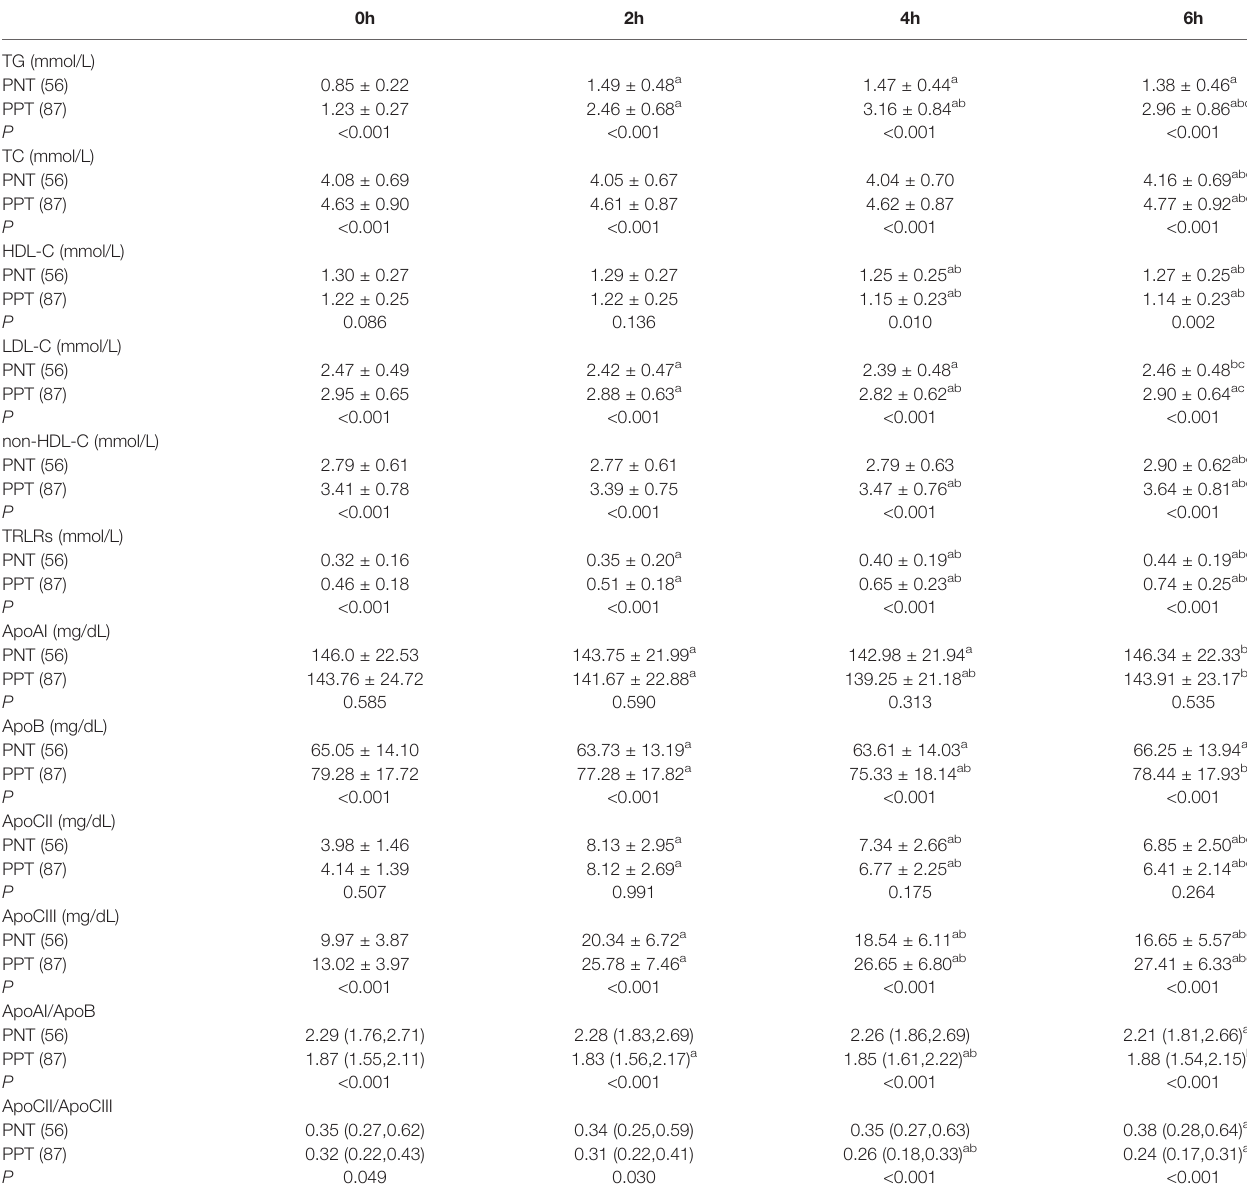
Values are presented as means ± SD. a P<0.05, compared with fasting levels in the same group; b P<0.05, compared with postprandial 2h levels in the same group; c P<0.05, compared with postprandial 4h levels in the same group. PNT, postprandial normal triglyceride; PPT, postprandial hypertriglyceridemia; TG, triglyceride; TC, total cholesterol; HDL-C, high-density lipoprotein cholesterol; LDL-C, low-density lipoprotein cholesterol; non-HDL-C, non-high-density lipoprotein cholesterol; TRLRs, triglyceride-rich lipoprotein remnants; ApoAI, apolipoprotein AI; ApoB, apolipoprotein B; ApoC Ⅱ , apolipoprotein C Ⅱ ; ApoCIII, apolipoprotein